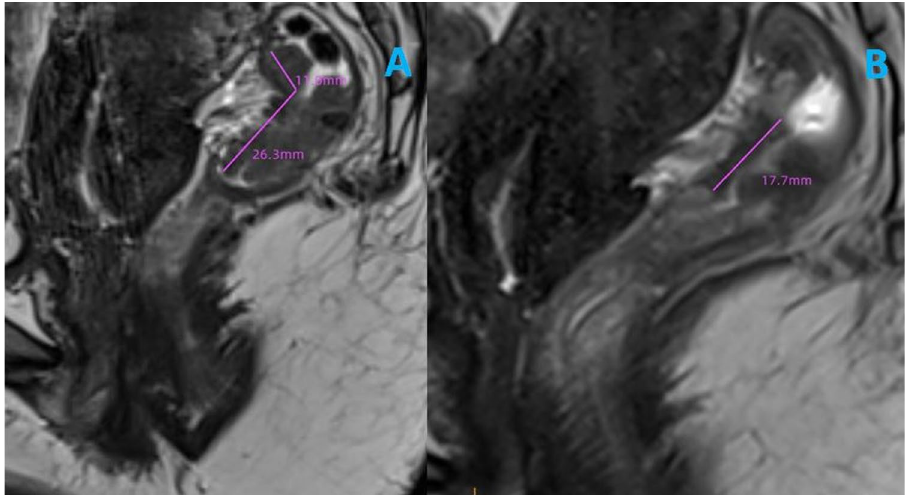
Fig. 2 The measurement of the maximum length diam- eter of tumor before and after nCRT. nCRT: nCRT: neoad- juvant chemoradiotherapy. A The purple line measures the length diameter of the primary rectal tumor before nCRT (37.3 mm). B The purple line measures the length diameter of the primary rectal tumor after nCRT (17.7